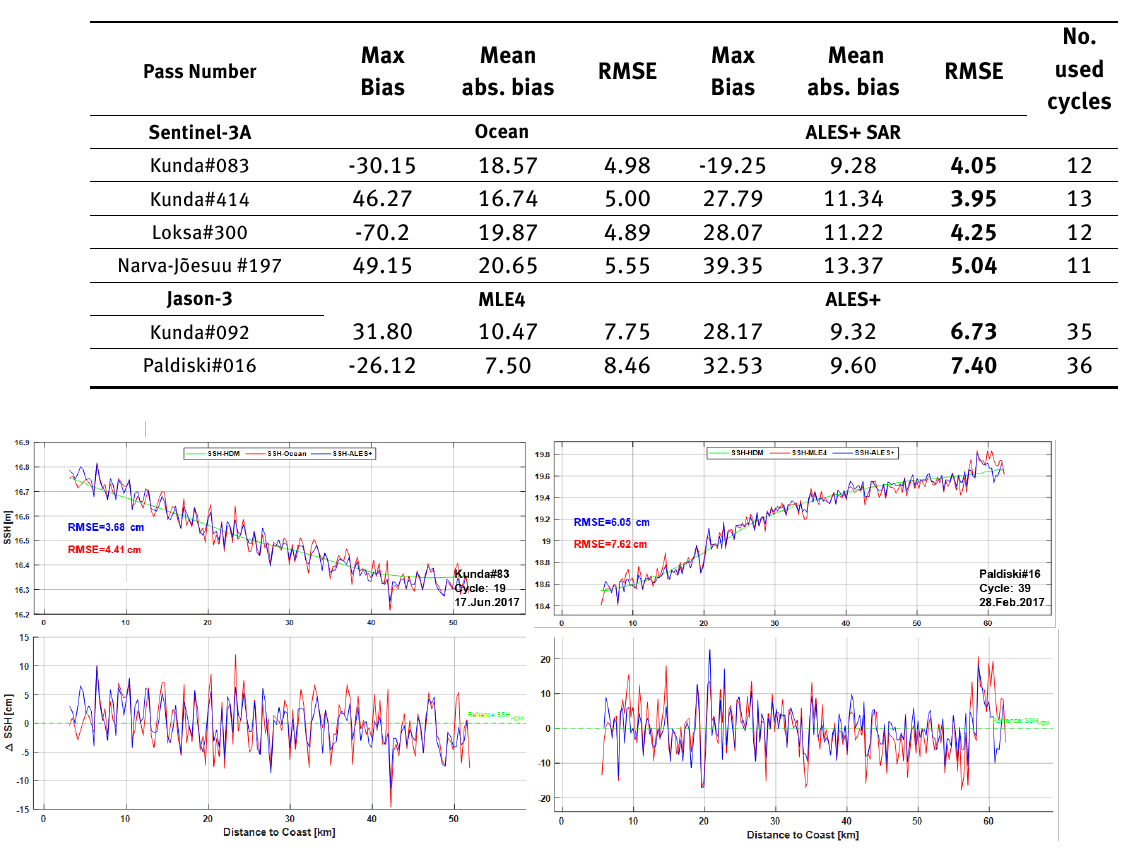
Figure 9: The along track SSH SA − corrected versus SSH HDM at two TG stations: Left: Kunda-083 Sentinel-3A using Ocean (red) and ALES+ SAR (blue) retrackers Right: Paldiski-016 Jason-3 using MLE4 (red) and ALES+ (blue) retrackers. The bottom plots show differences ∆ SSH be- tween SSH SA − corrected and SSH HDM